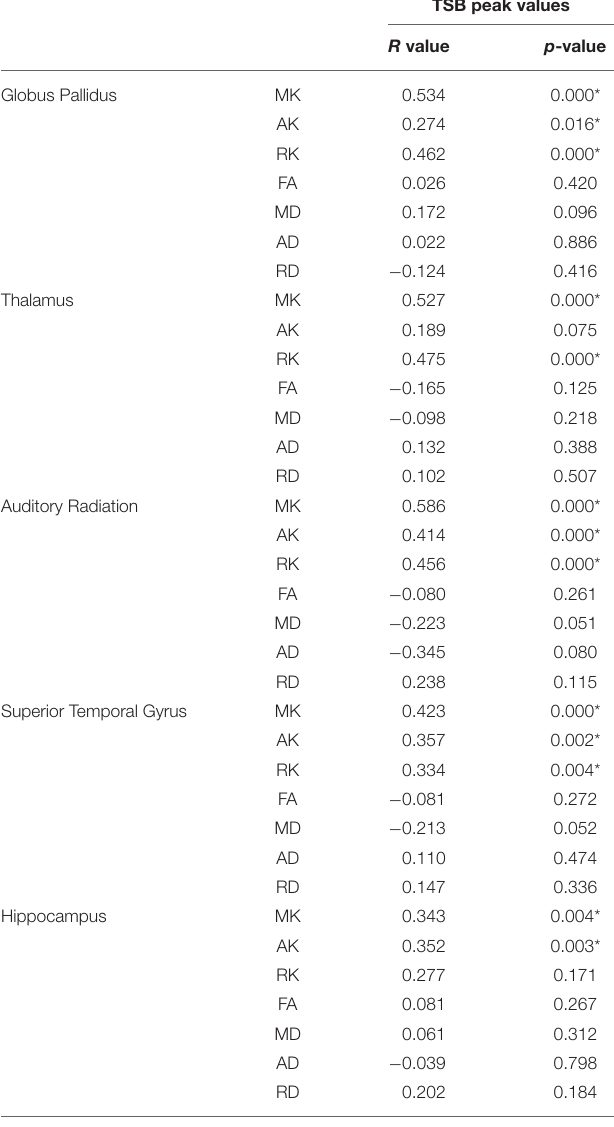
TABLE 4 | Correlation between peak TSB values and DKI parameters of each